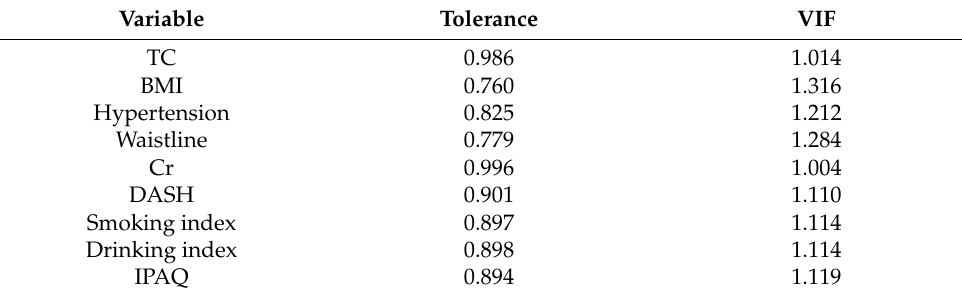
Table 2. Multicollinearity test of predictor variables.